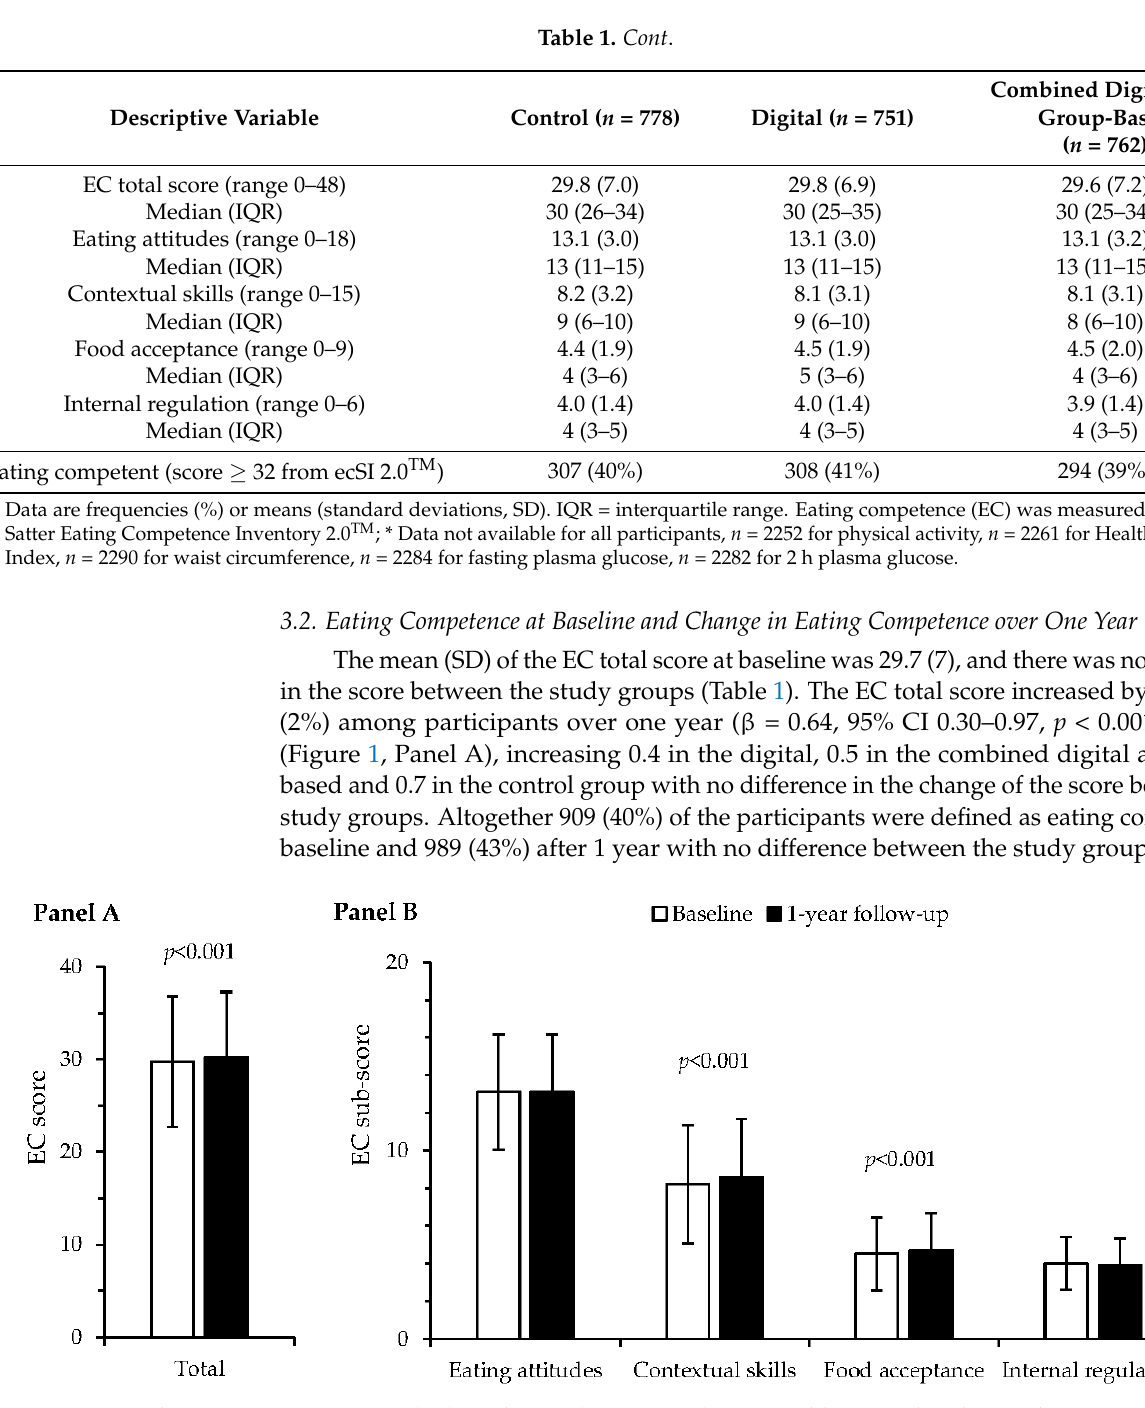
Figure 1. Panel A. Eating Competence (EC) total score (mean ± SD) increased between baseline and one year in the whole study group ( p < 0.001 for time), but there were no differences between the study groups. Panel B. EC sub-scores (mean ± SD) of contextual skills ( p < 0.001 for time) and food acceptance ( p < 0.001 for time) increased between baseline and one year in the whole study group, but there were no differences between the study groups. Linear mixed effects model, n = 2291.